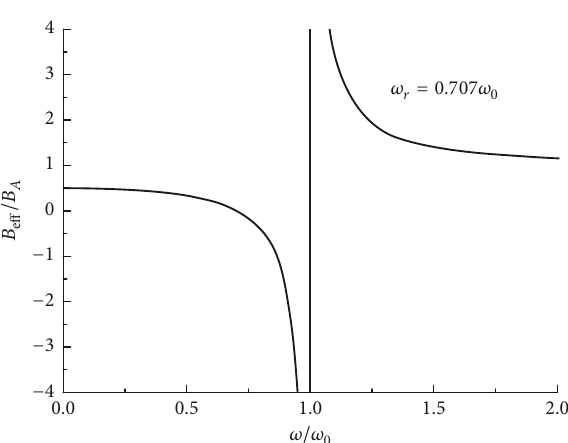
Figure 3: Effective bulk modulus of the unit cell obtained from the analytical